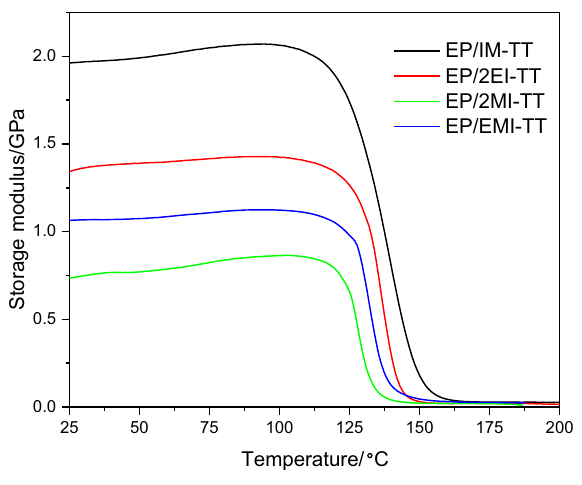
Fig. 11 Storage modulus of EP blends with triazine-trione based tri-imidazole derivatives